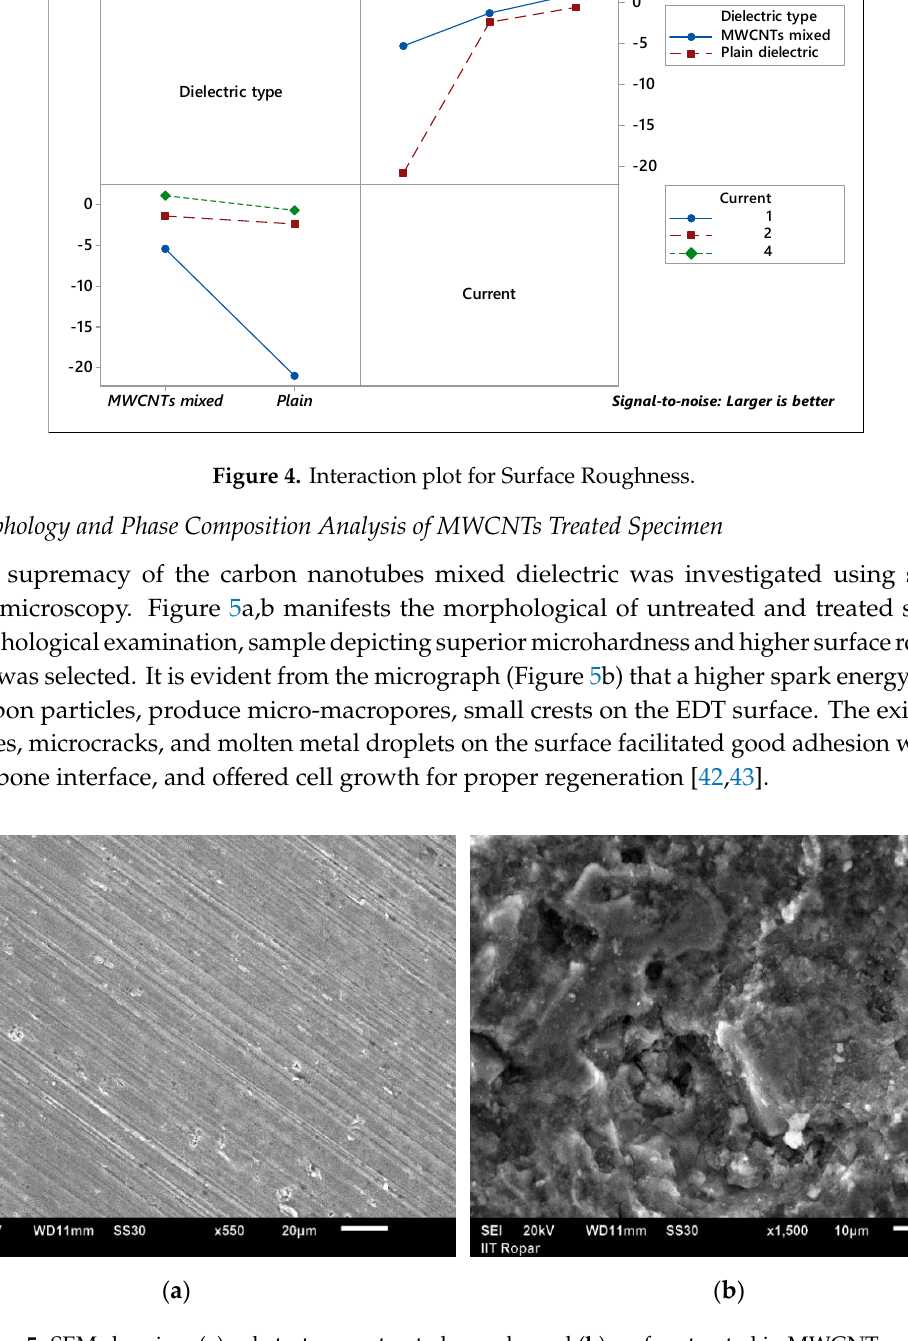
dielectric (trial 17) representing micro cracks, porous surface and molten metal droplets.